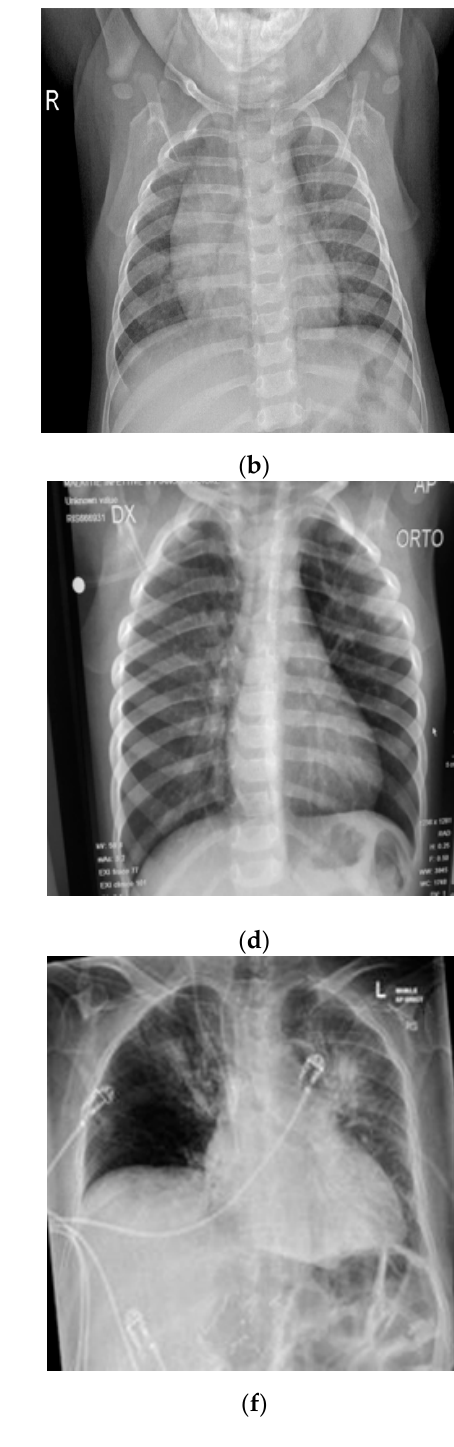
Figure 1. Samples of chest X-ray images assessed via Kaggle database [30–32] for training purposes: ( a – c ) normal chest X-rays; ( d – f ) COVID-19 chest X-rays.